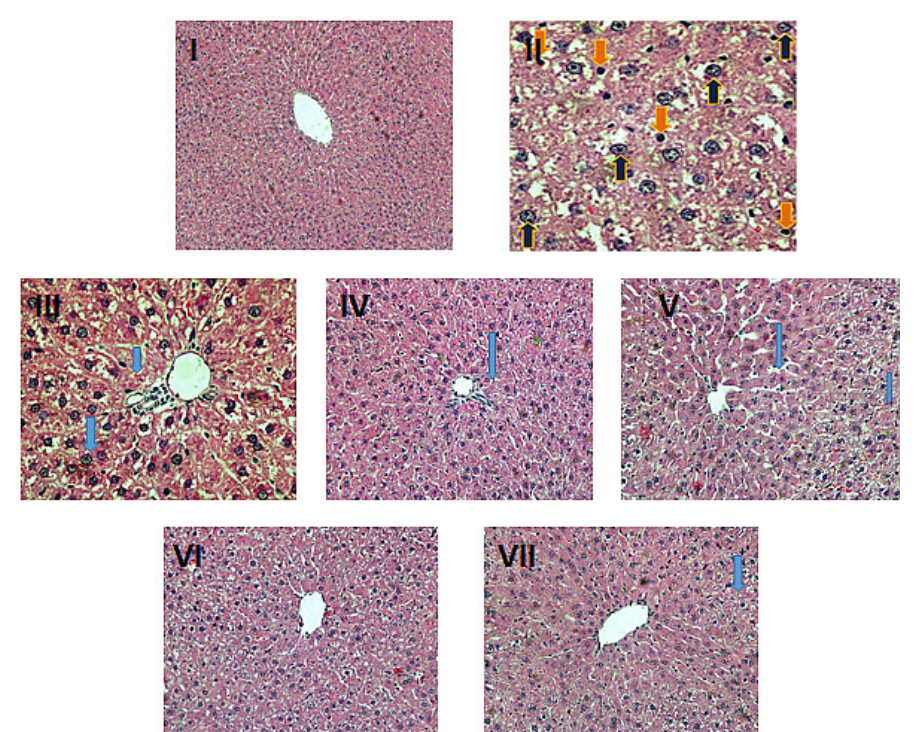
Figure 7. Histomicrographs of liver samples of the indicated groups in parentheses. All sections were stained with hematoxylin and eosin and snapped at 400× (Leica, Munich, Germany).